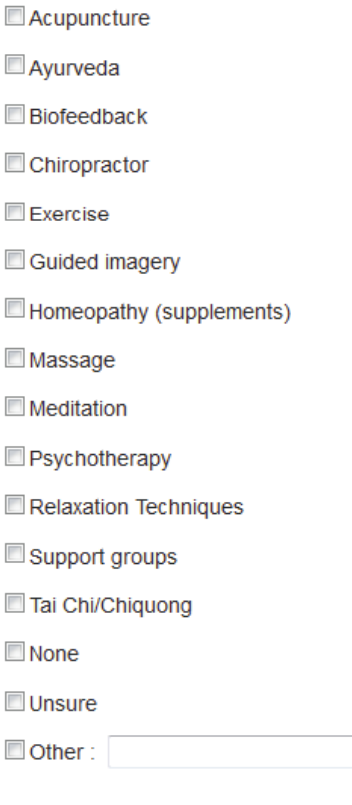
Supplemental Figure 6. Alternative/complimentary